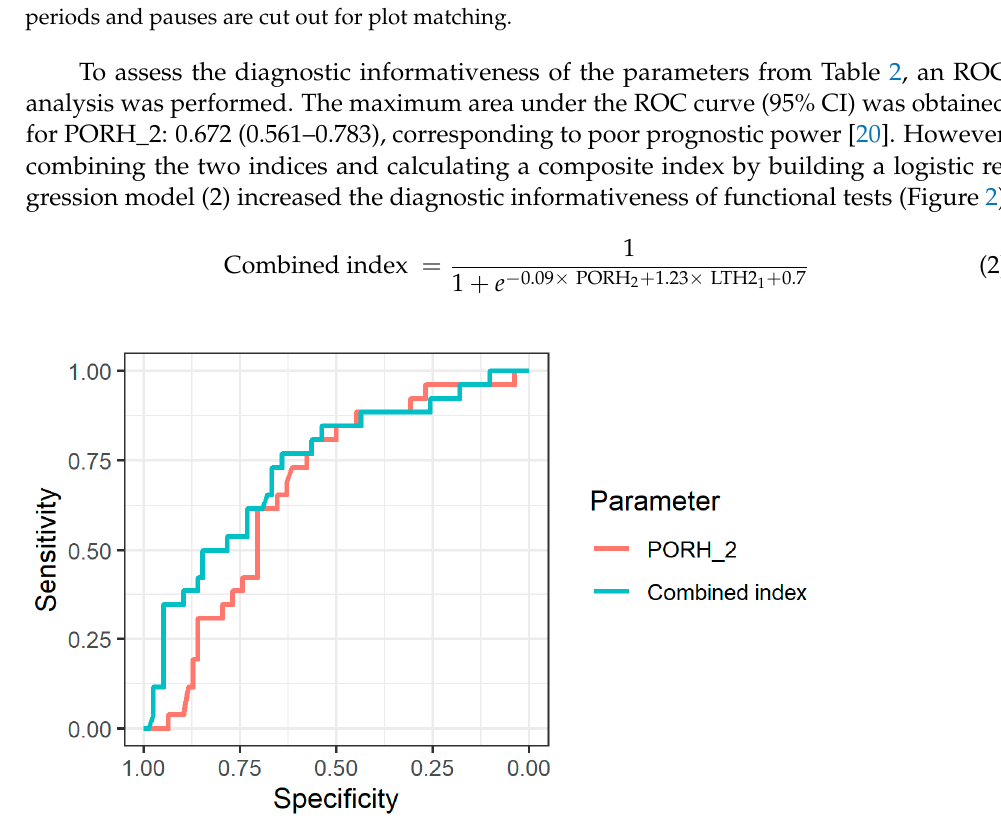
Figure 2. ROC curves for identifying patients from Group 2 using the PORH_2 index and using the combined index.